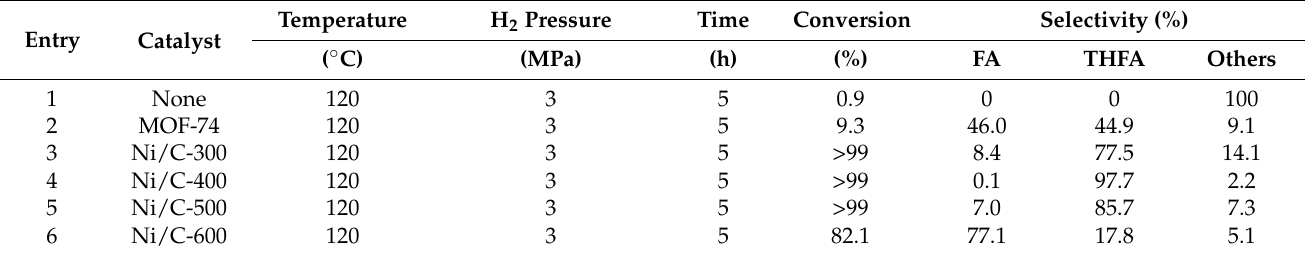
Table 1. The catalytic performance of MOF-74 and derived Ni/C catalysts.